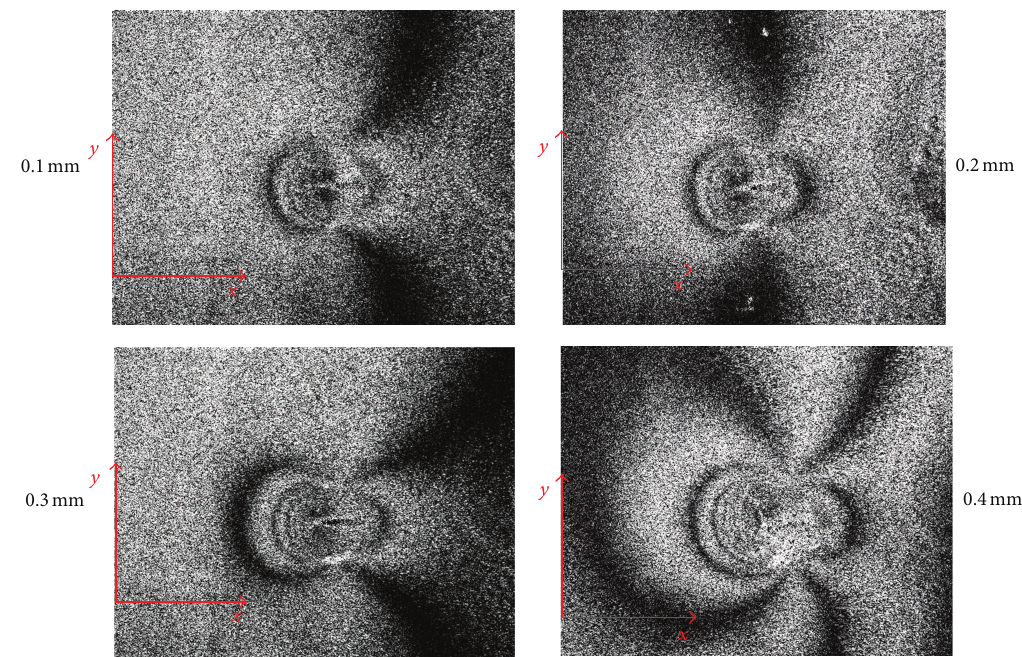
Figure 3: Speckle correlation fringes recorded after four drilling increments obtained by subtraction the real time recorded pattern from the initial reference pattern.